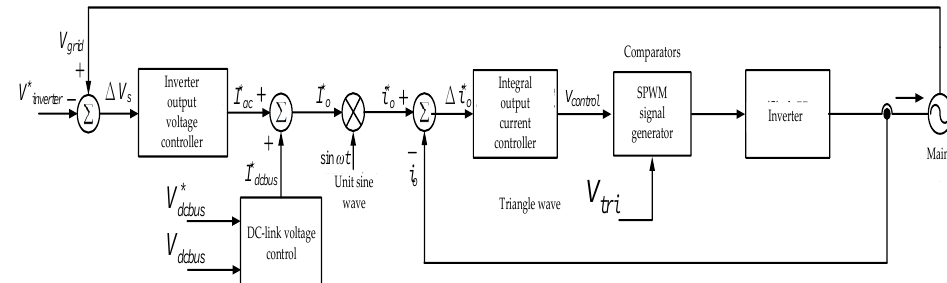
Figure 5. Control architecture of photovoltaic inverter output. Figure 5 derives each control variable shown in Equation (11) to Equation (14).